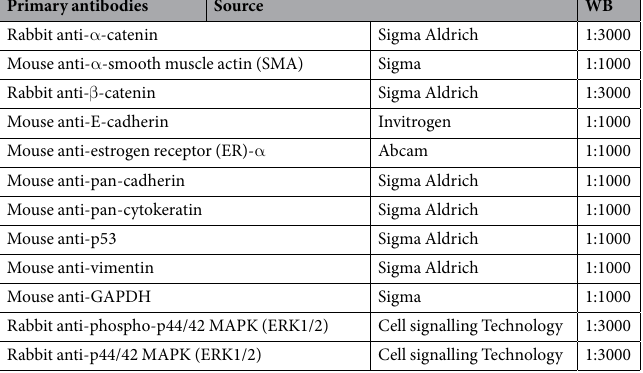
Table 2. Primary antibodies used in western blot